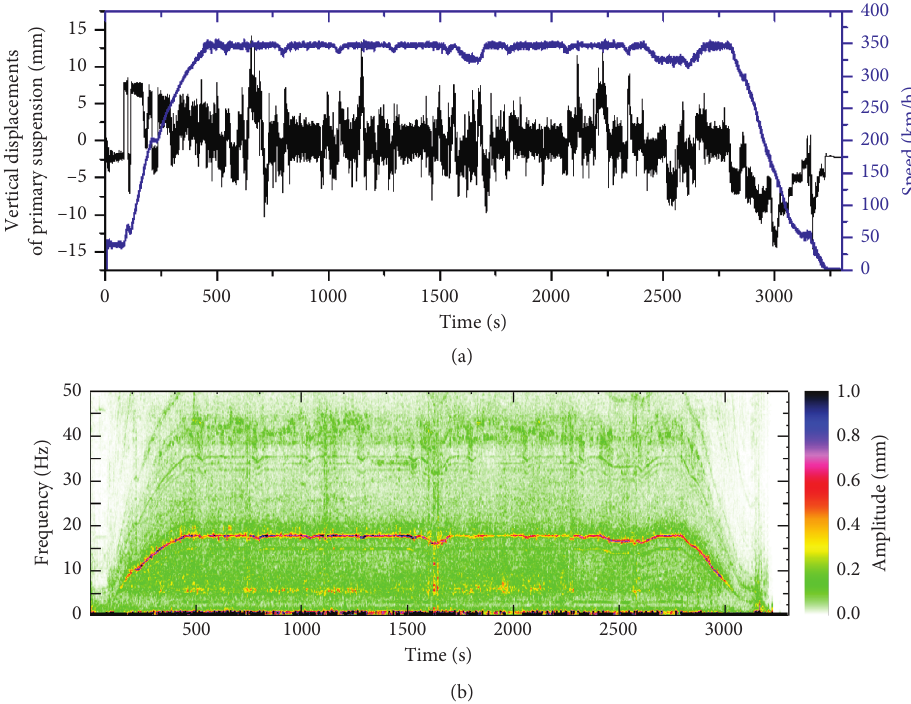
Figure 16: Slab segment-induced responses in the displacement of the primary suspension: (a) time history of the vertical displacement of the primary suspension and vehicle speed profile; (b) short-time Fourier transform of vertical displacements of the primary suspension obtained on a high-speed train running on the ZX high-speed railway